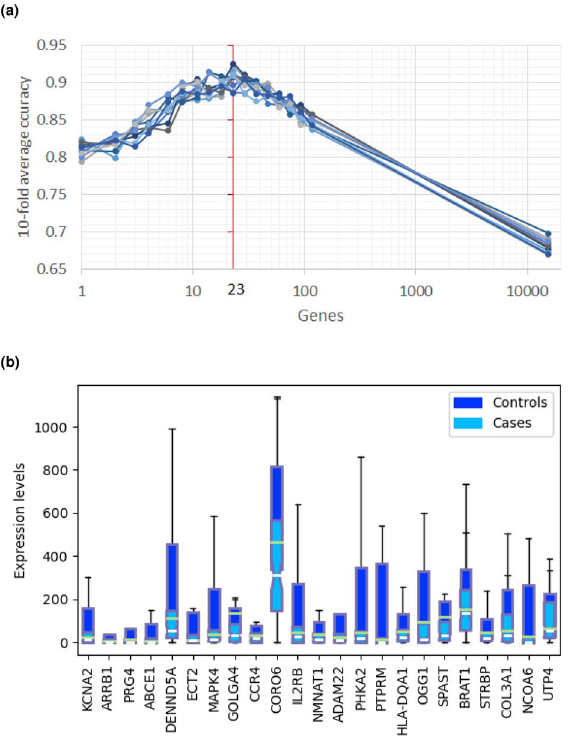
Figure 1. Results of the REFS algorithm run ten times on the mRNA expression data of 118 samples from the CAMDA dataset. ( a ) The optimal number of predictor genes to distinguish 93 cases from 25 controls was 23 (red vertical line). ( b ) mRNA expression levels of the 23 predictor genes for 93 cases (light blue) and 25 controls (dark blue) in box-and-whisker plots. Outliers were omitted for visualization purposes.